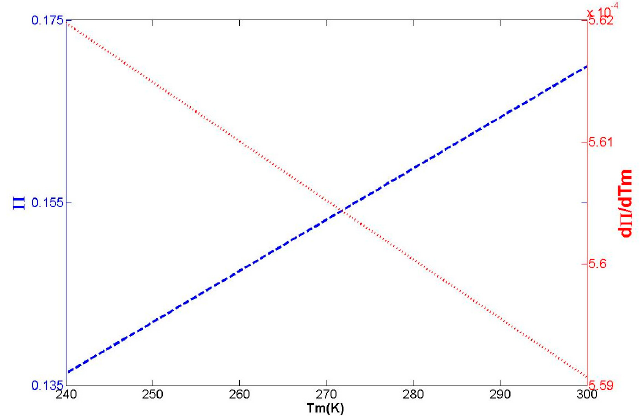
Figure 7. Change of Π and its first derivative with respect to T m .